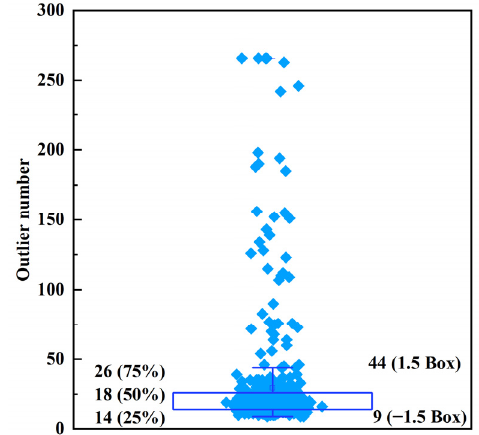
Figure 3. Box plot of outlier number of each room.